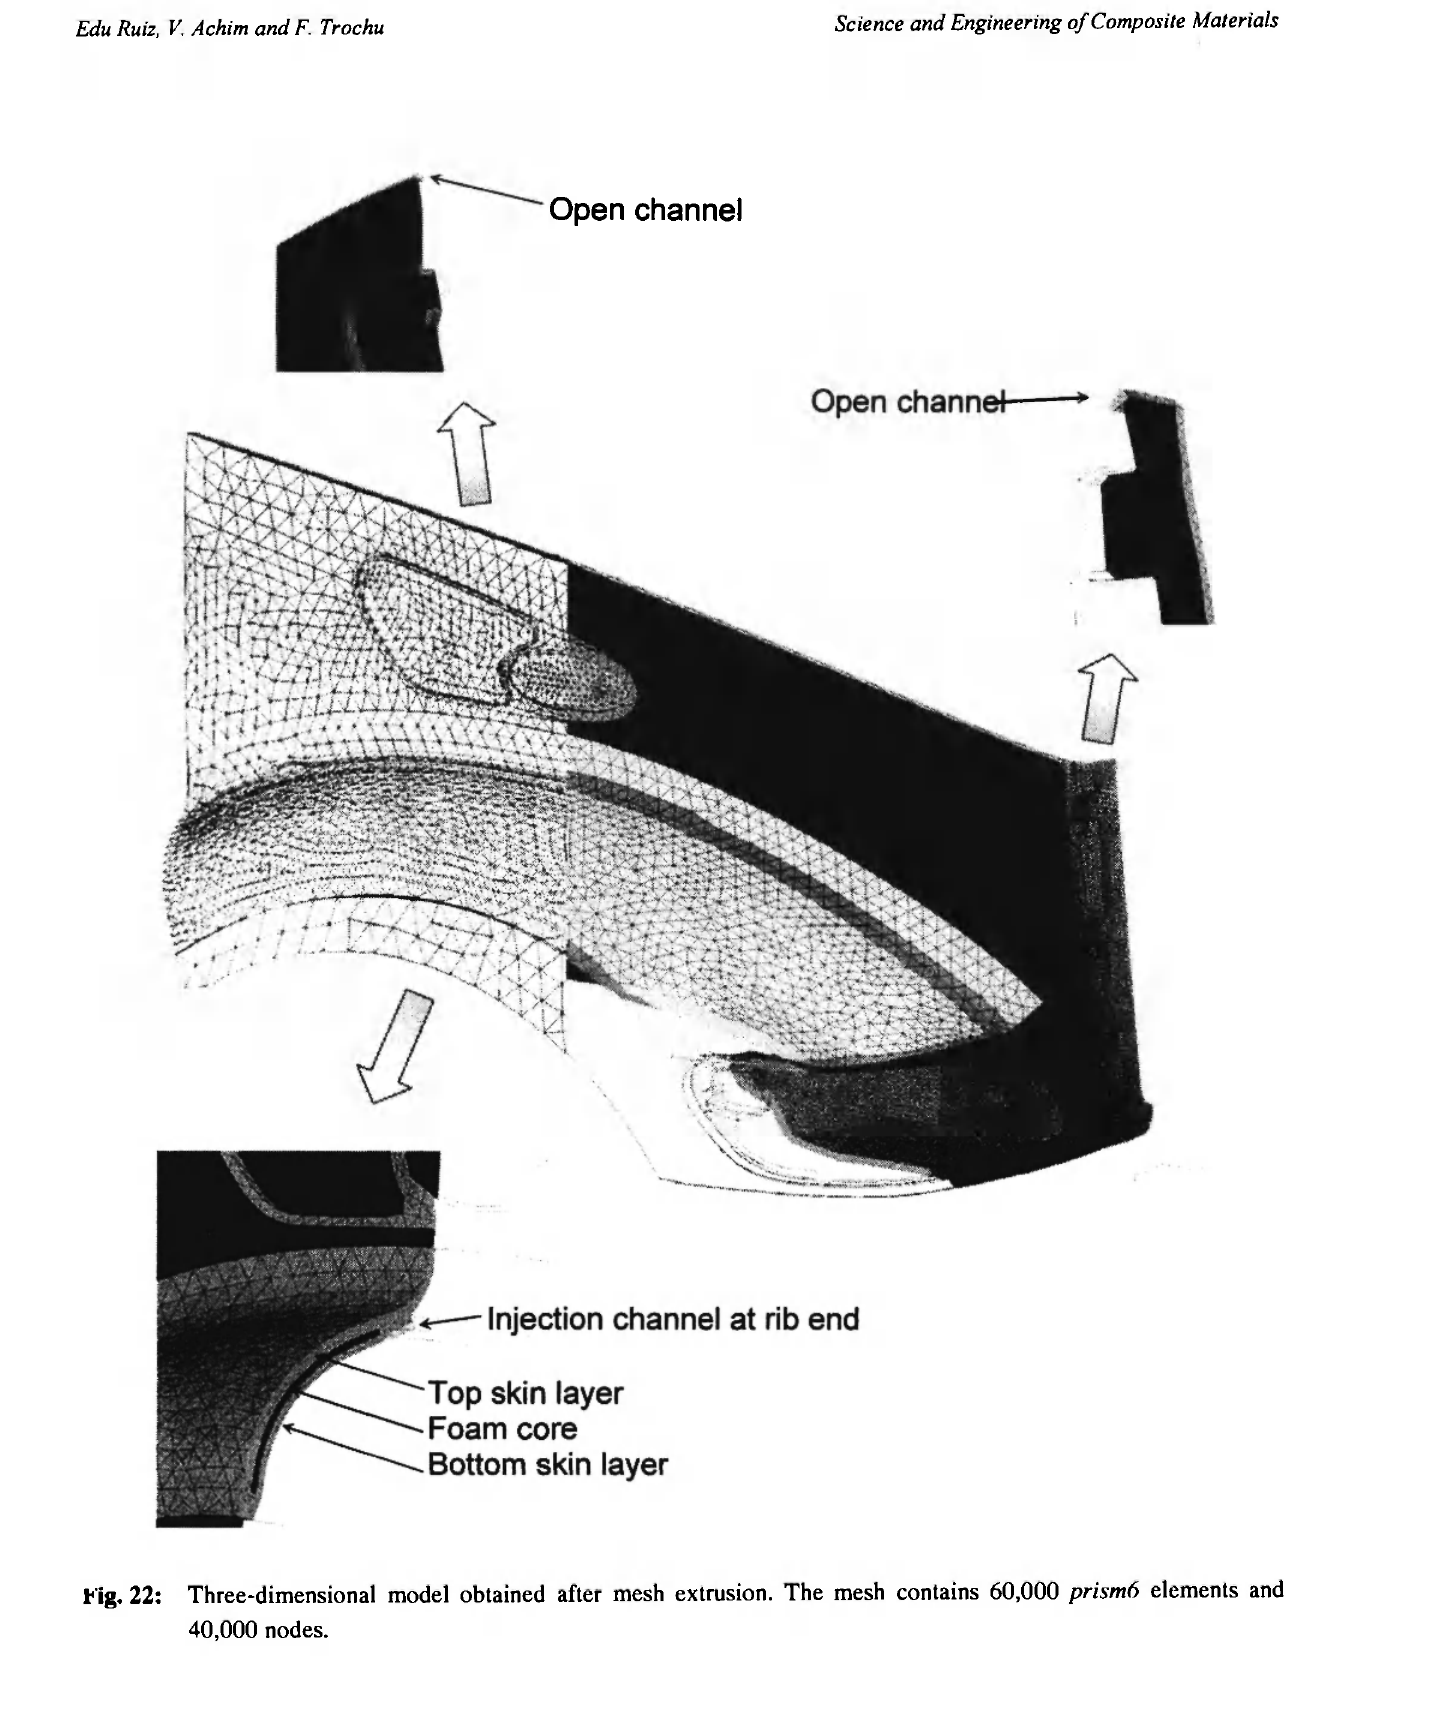
Fig. 22: Three-dimensional model obtained after mesh extrusion. The mesh contains 60,000 prism6 elements and 40,000